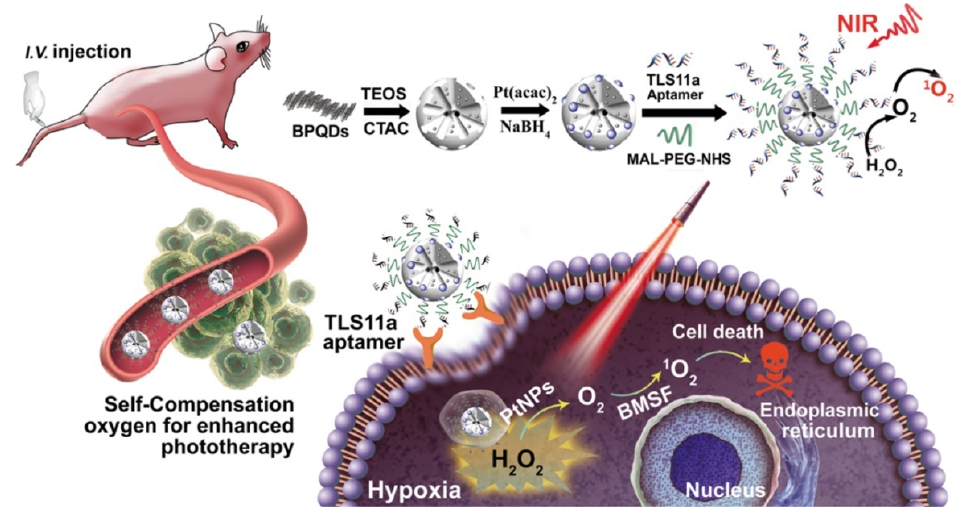
Figure 7. Case diagram of a mesoporous silicon metal framework using black phosphorus quantum dots for photodynamic therapy. Reprinted with permission from Ref. [86]. Copyright 2019 ACS publications.